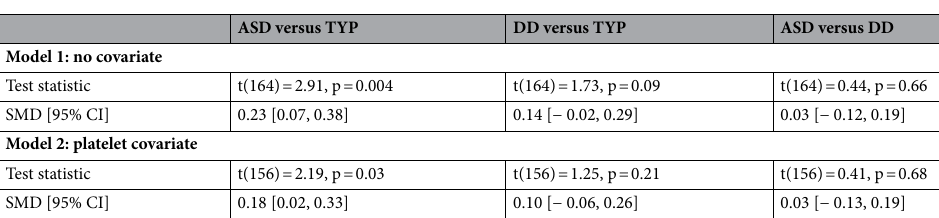
Table 2. Results of primary and secondary models comparing BDNF concentration (square-root transformed) among study groups. SMD standardized mean difference, CI confidence interval, ASD autism spectrum disorder (n = 94), TYP typical development (n = 52), DD developmental delay (n = 21). Outcome was square-root transformed BDNF (pg/mL). SMD was calculated using estimated mean difference. Model 1 was also performed with complete cases (i.e., excluding the seven TYP participants without platelet count); effect size estimates were identical to those shown in this table (see Supplementary Materials). Full results for all models are shown in the Supplementary